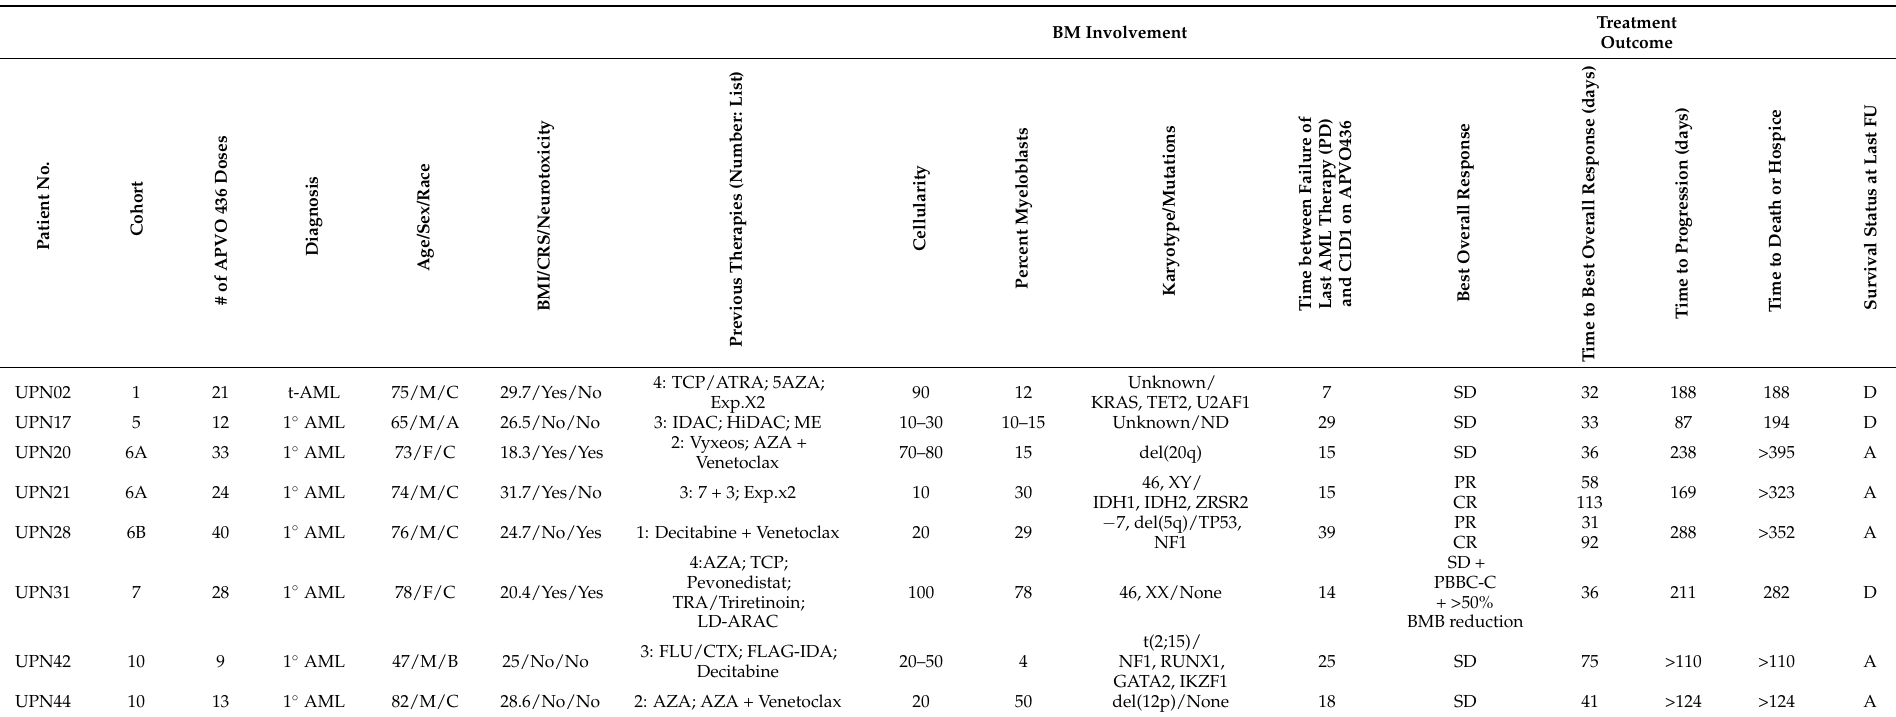
Table 4. Patient characteristics and demographic features of APVO436-treated AML patients with favorable responses. BM Involvement Treatment